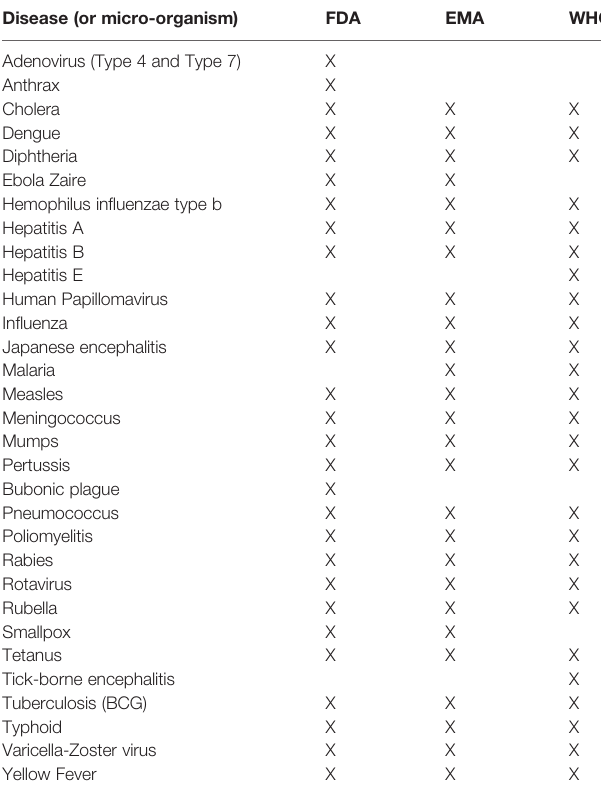
TABLE 1 | List of infectious diseases for which at least one vaccine is available according to the Food and Drug Administration (FDA), European Medicines Agency (EMA) and/or World Health Organization